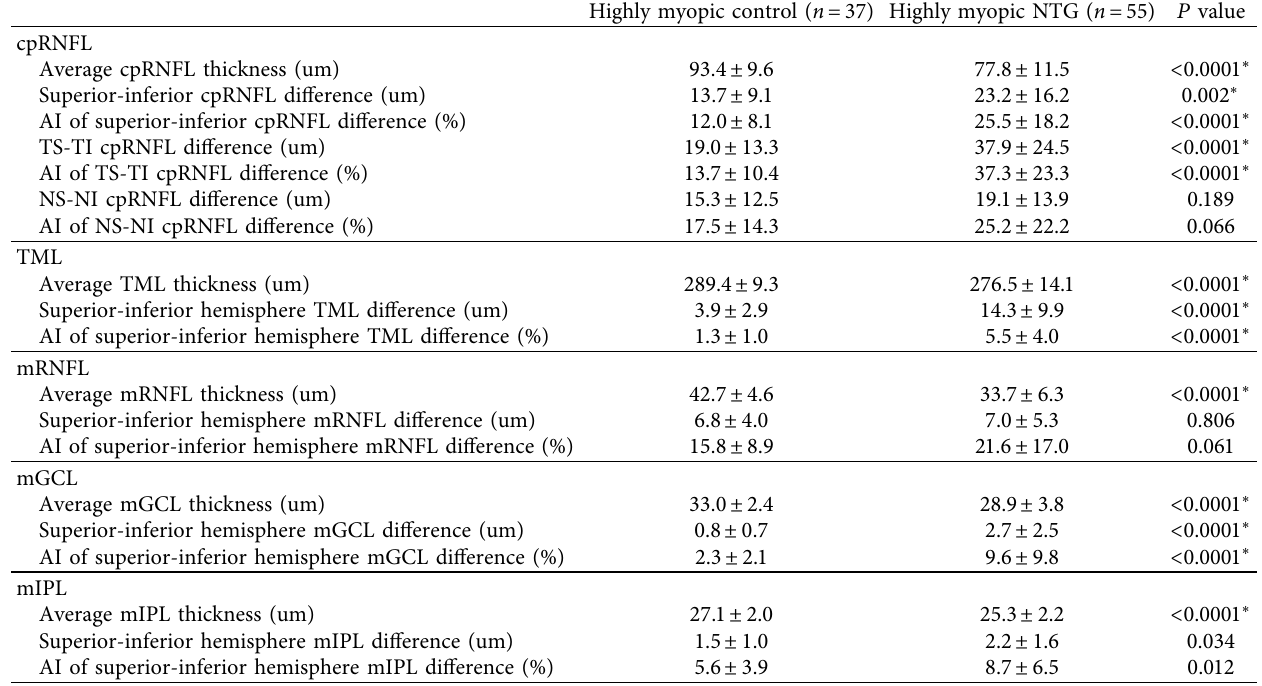
Table 2: Average thicknesses and hemisphere thickness differences of circumpapillary retinal nerve fiber layer, total macula layer, macular retinal nerve fiber layer, macular ganglion cell layer, and macular inner plexiform layer in highly myopic control subjects and highly myopic normal-tension glaucoma